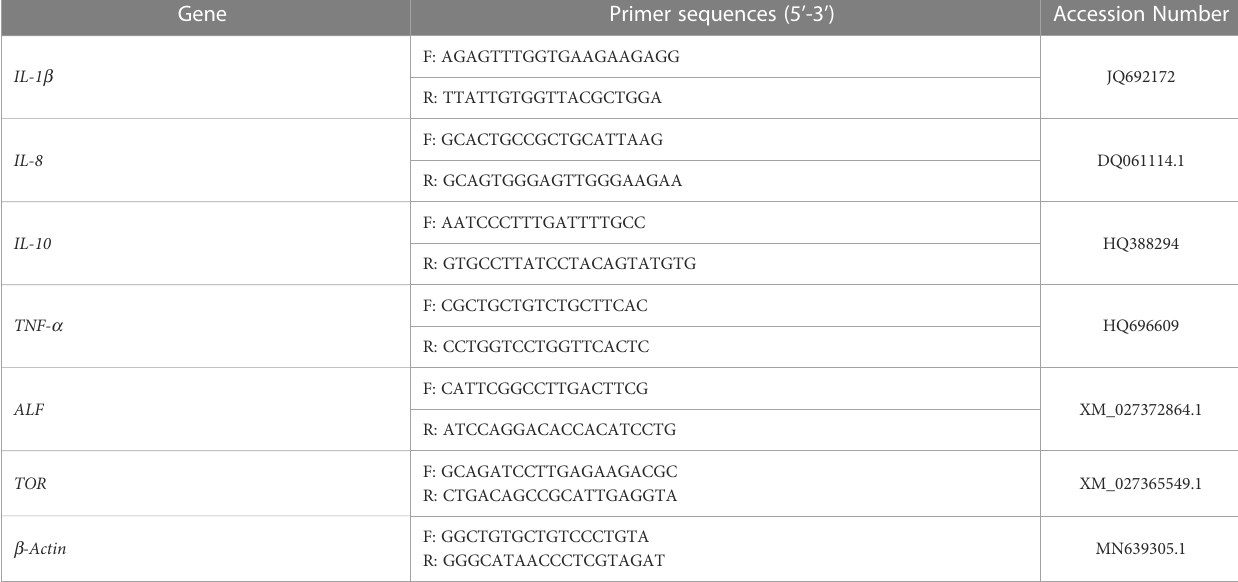
TABLE 2 Primer sequences for